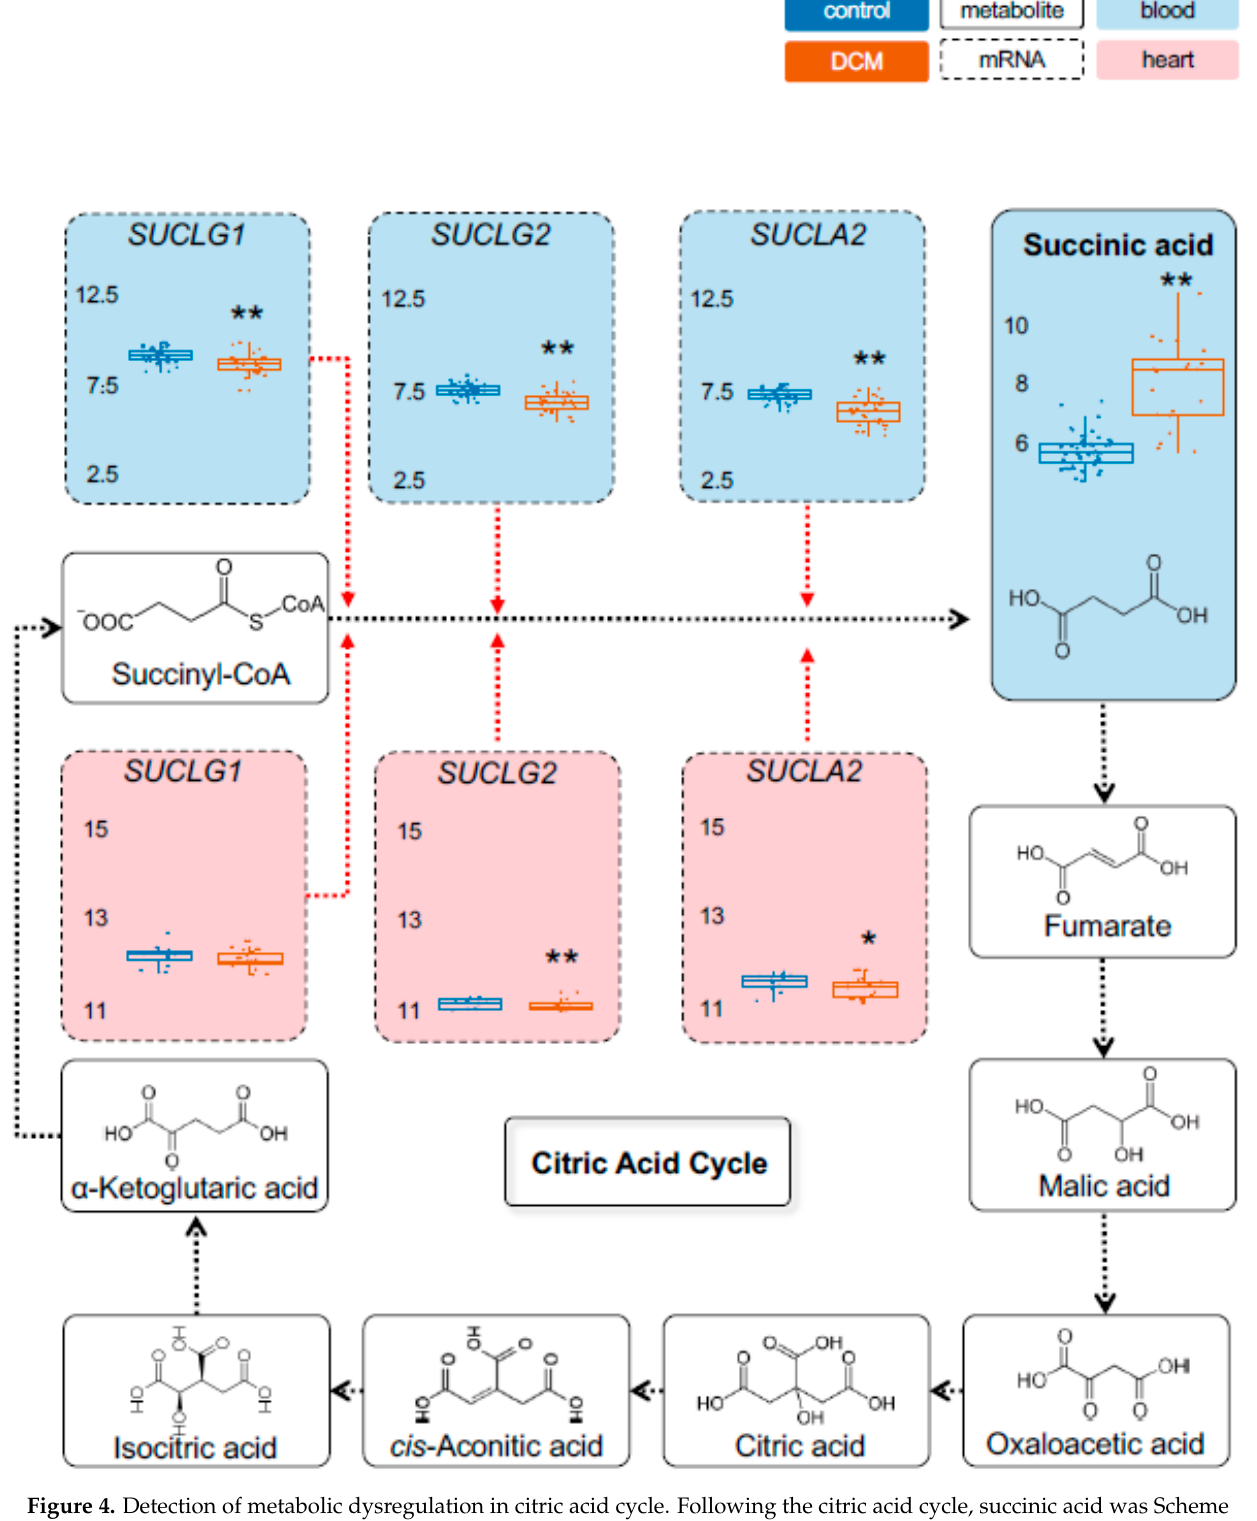
Figure 4. Detection of metabolic dysregulation in citric acid cycle. Following the citric acid cycle, succinic acid was Scheme 1. HF cohort, coinciding with decreased mRNA levels of several enzymes in blood. Same color and symbol annotation as in Figure 3. RNAseq expression is given as (rlog-)normalized read counts. Metabolite concentrations are shown as [µM]. *: p < 0.05; **: p < 0.01. SUCLG1 = Succinate-CoA Ligase Alpha Subunit; SUCLG2 = succinate-coA ligase GDP-forming beta subunit; SUCLA2 = succinate-coA ligase ADP-forming beta subunit.